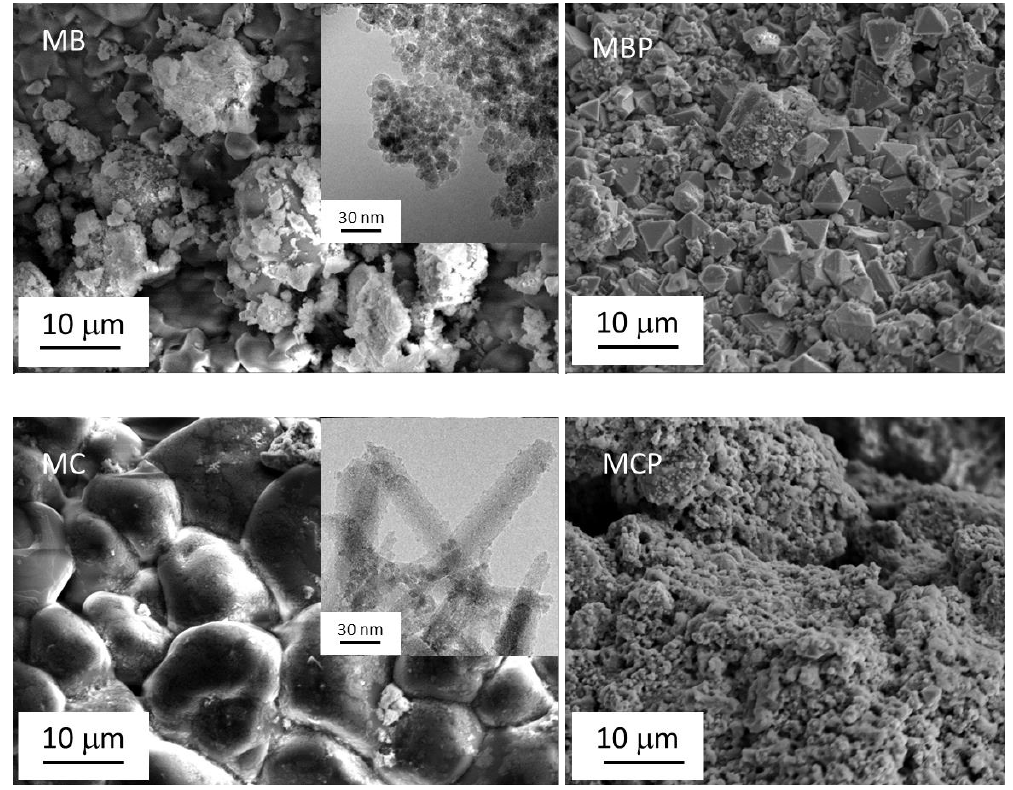
Figure 2. Scanning Electron Microscopy (SEM) images of MB, MC and parent pyrolyzed samples. The inset shows the Transmission Electron Microscopy (TEM) images related to the samples before pyrolysis.